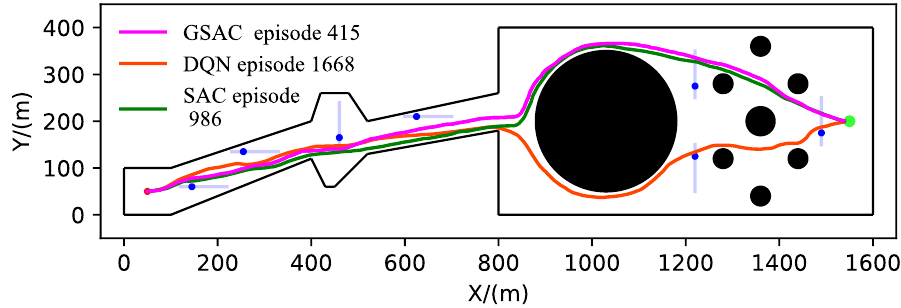
Figure 12. Dynamic environment trajectory. • : AUV; • : Goal; (cid:4) : Obstacle; • : Dynamic obstacle; —: Dynamic obstacle trajectory; —: